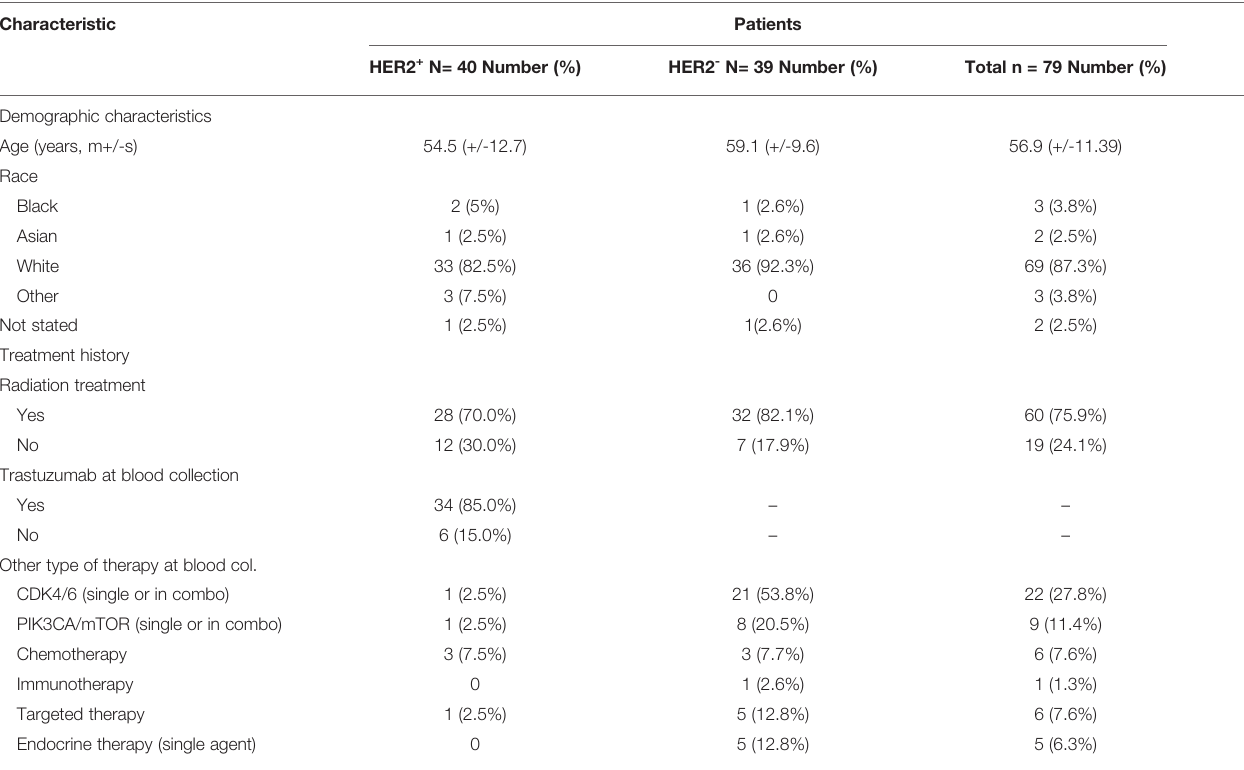
TABLE 3 | Patient demographics and